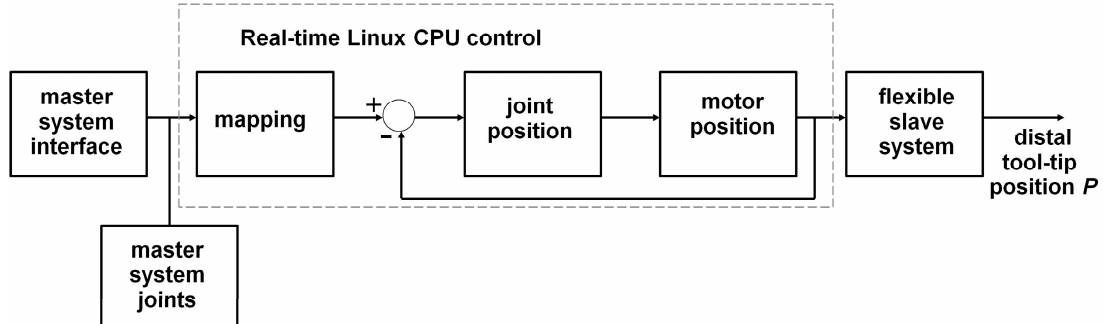
Figure 3. Master–slave control flow chart of the robotic system. In the ‘mapping’ block, the horizontal rotation of the master system handle is mapped to the rotation of the follower, the translation of the master is mapped to that of the follower, and the vertical rotation of the master is mapped to the bending angle of the follower as shown at the bottom of Figure 2. The mapping scales are indicated in the text here below.